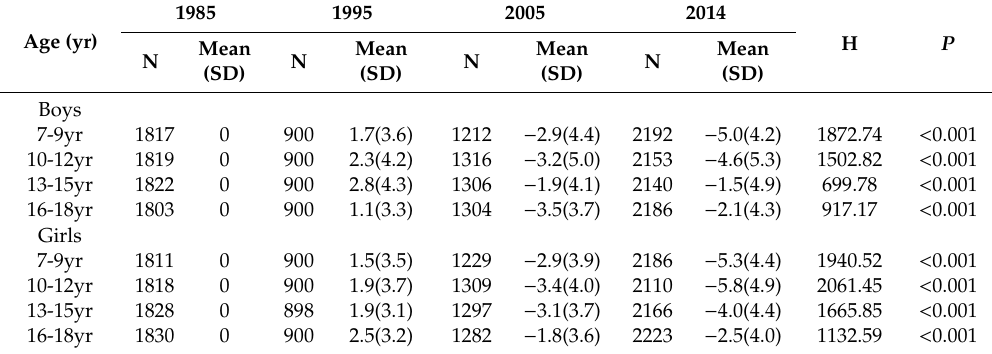
Table 3. Physical fitness indicators of children and adolescents in Xinjiang for different age groups, 1985 to 2014.